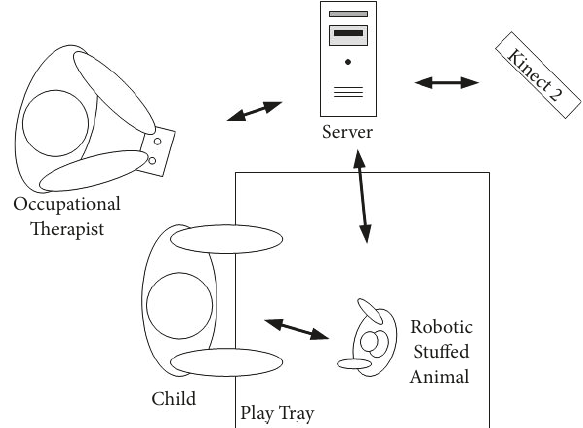
Figure 2: Diagram of the communication between hardware com- ponents when using the SAR during this study. The child interacts only with the SAR, which is controlled by the investigator in the room through commands sent to an external server.